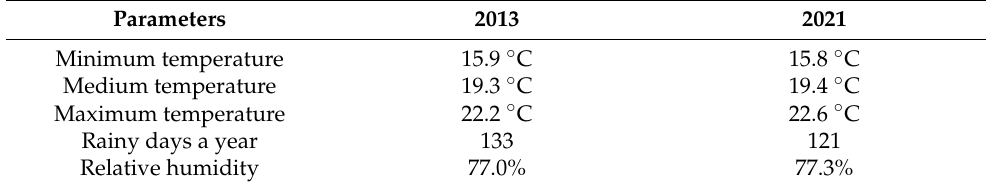
Table 3. Climatic conditions in Sambuca di Sicilia, expressed as an average in the years 2013 and 2021, as provided by the